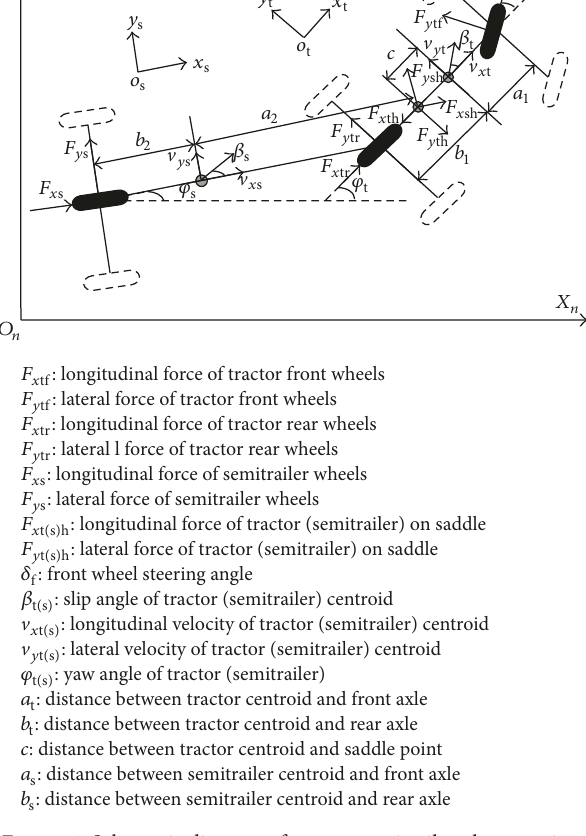
Figure 1: Schematic diagram of tractor-semitrailer plane